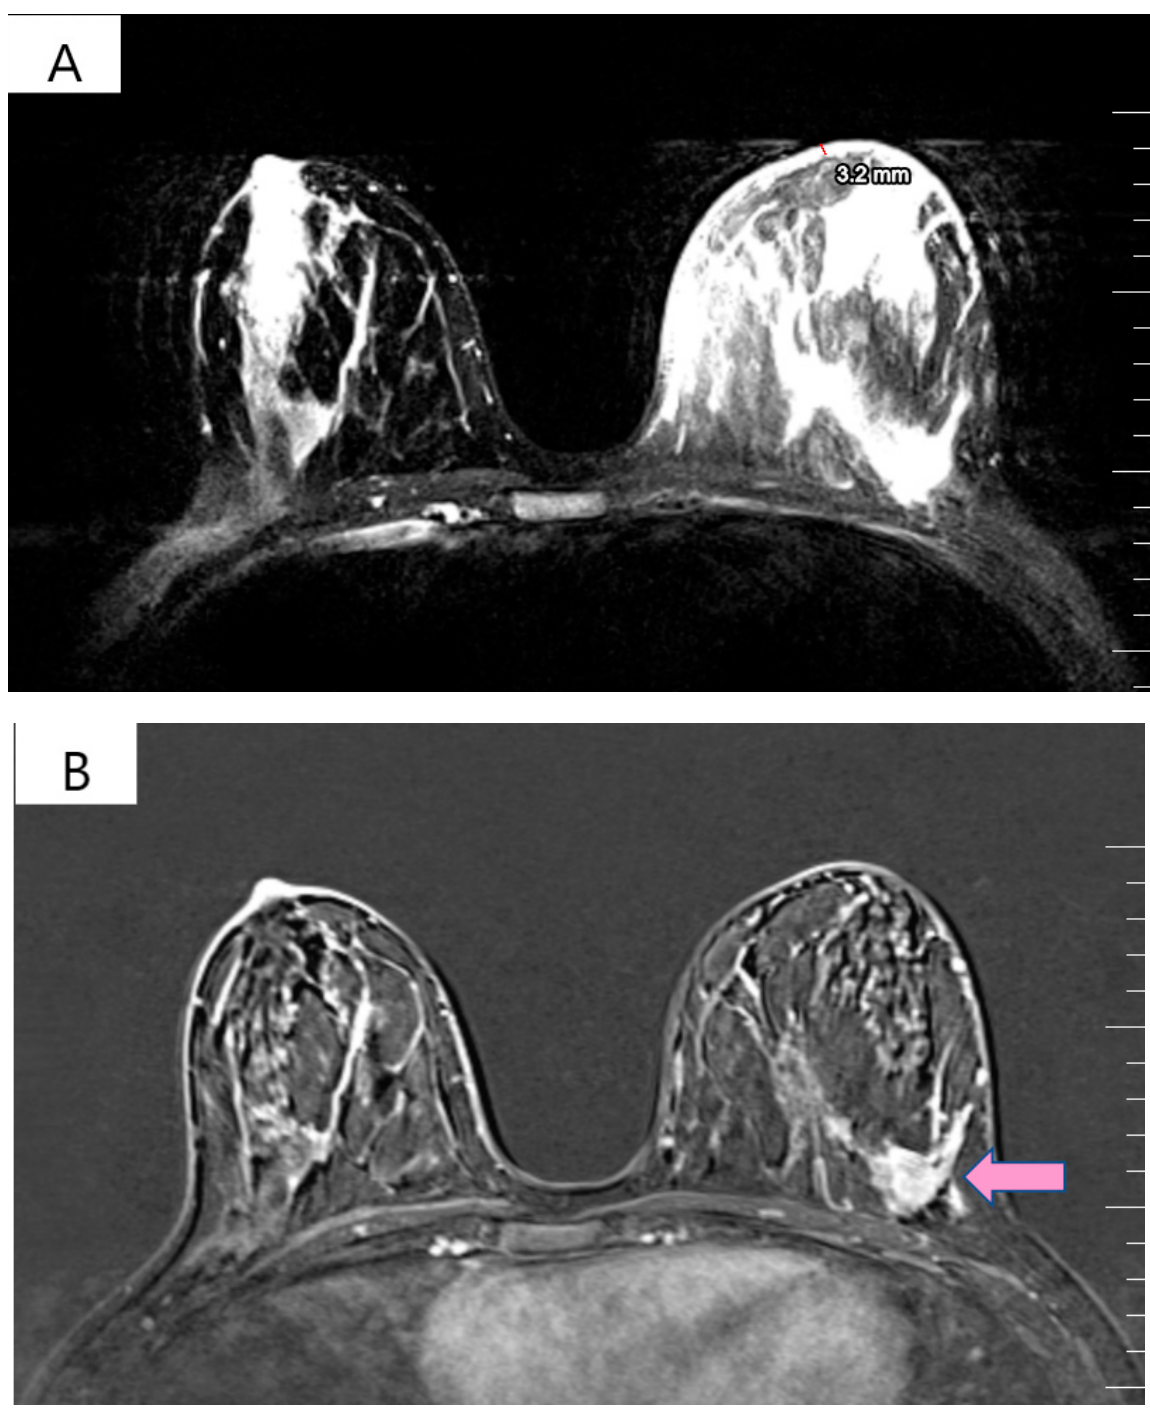
Figure 1. ( A ) T2 weighted MRI of left breast demonstrating skin thickening (3.2 mm) associated with hypersignal suggestive of edema. ( B ) T1 weighted MRI showing the regional contrast sample located in the lower outer quadrant extending to the upper outer quadrant (marked by arrows).